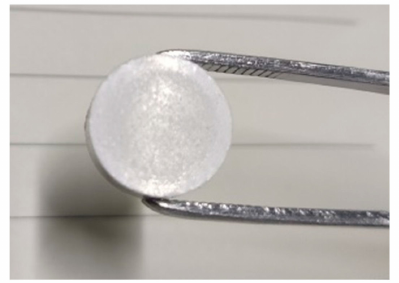
Figure 2. Pyrolysis precursor piece.